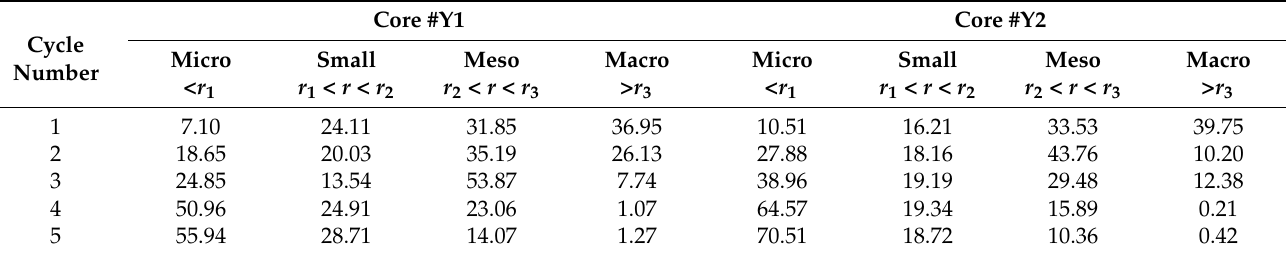
Table 4. Percentage of oil production in different pore scales